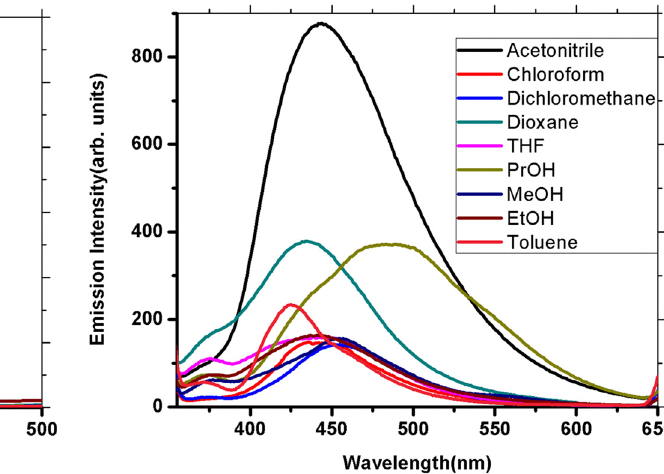
Figure 1: Electronic absorption spectra of 1 × 10 − 5 mol L − 1 of DTTP in di ff erent solvents.